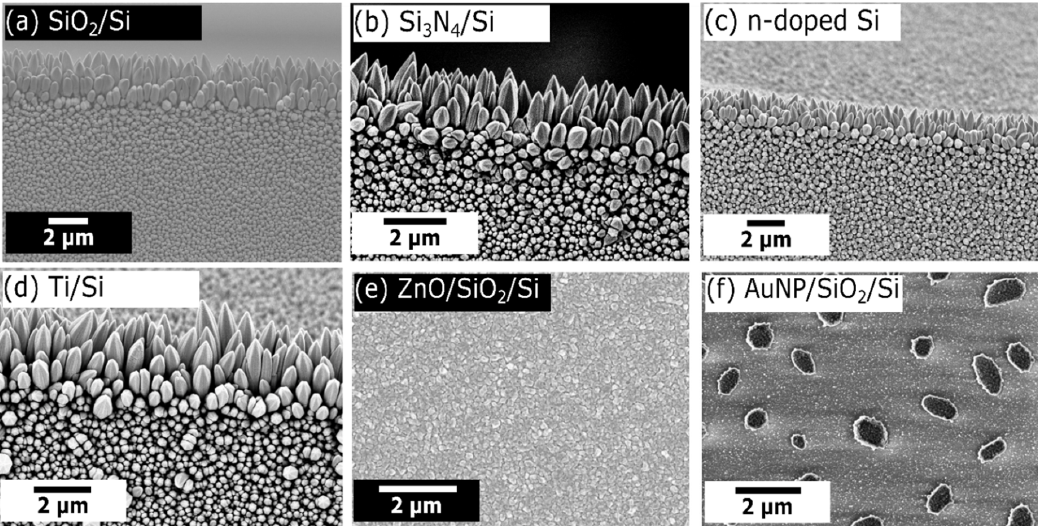
Figure 7. SEM pictures of nanowhiskers grown on different substrate types. The material of the substrate was ( a ) 100 nm SiO 2 /Si, ( b ) 100 nm Si 3 N 4 /Si, ( c ) n-doped Si, ( d ) 40 nm Ti/Si, ( e ) 30 nm ZnO/100 nm SiO 2 / Si and ( f ) gold nanoparticles (average diameter 67 ± 25 nm) on 100 nm SiO 2 /Si.